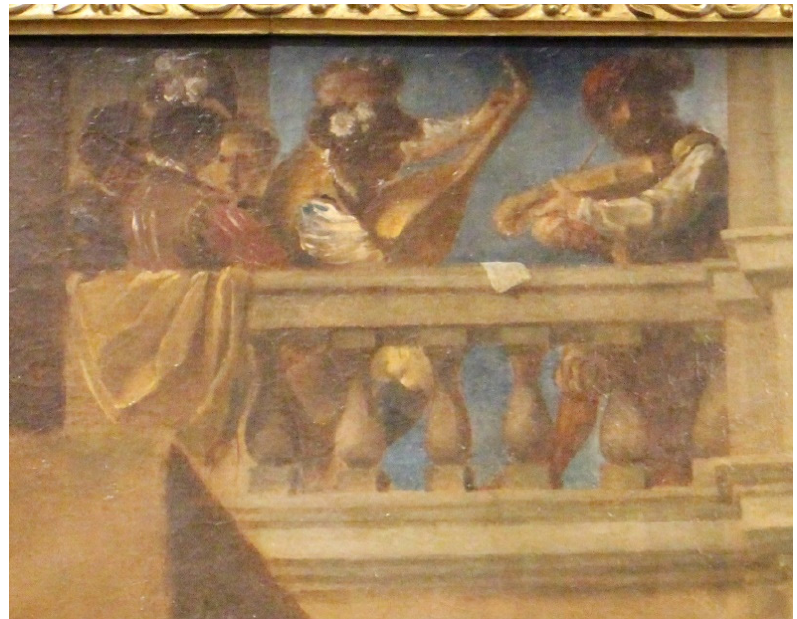
Figure 2. Guercino, Return of the Prodigal Son (detail), 1618, Galleria Sabauda, Turin. Photo: © Daniel M. Unger.